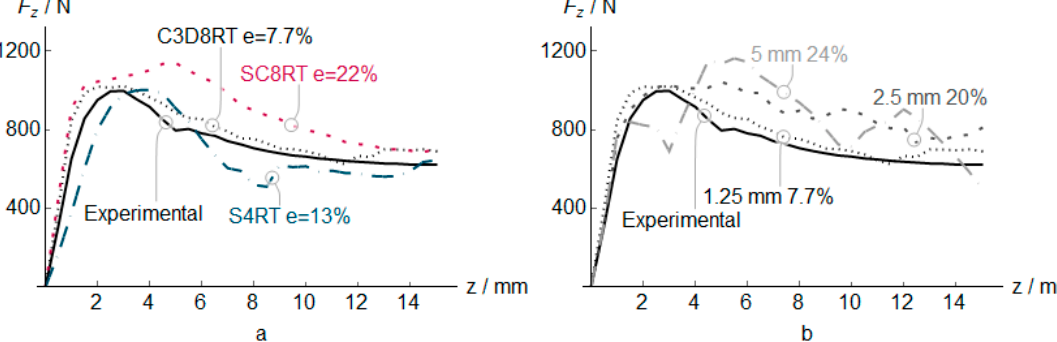
Figure 4. Vertical force F z in PVC incremental forming. Experimental vs. predicted mean values at z positions, and estimation error e for different elements ( a ), and different C3D8RT sizes ( b ).